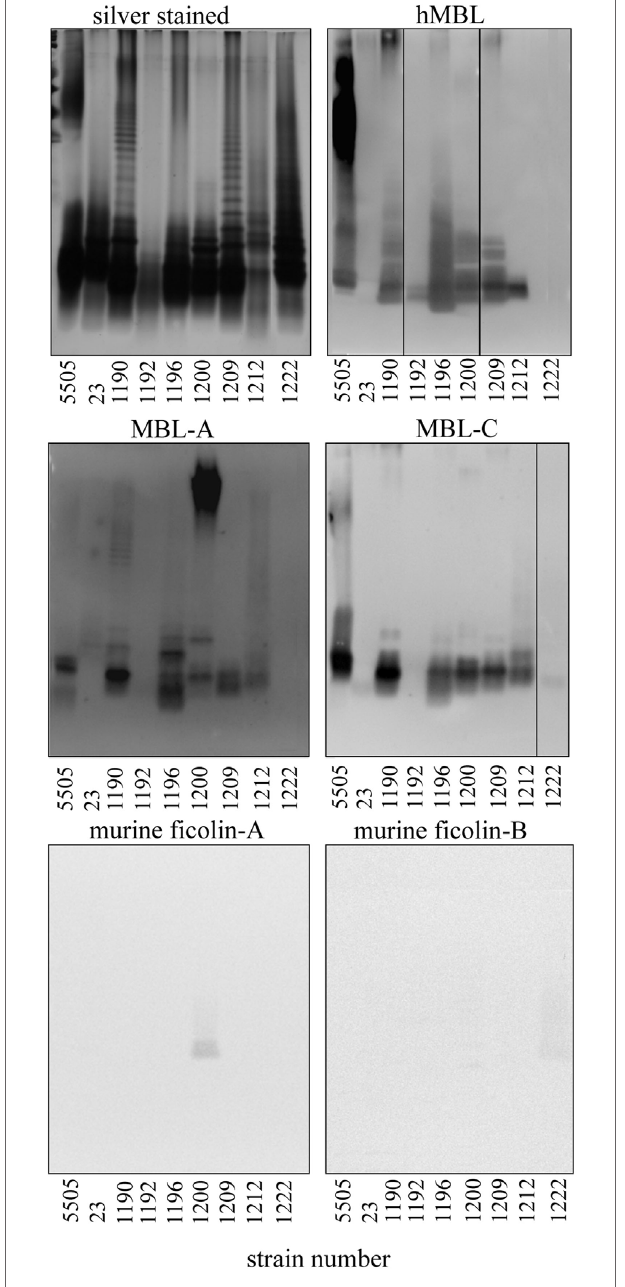
FigUre 3 | Silver stained SDS-PAGE of representative Hafnia alvei lipopolysaccharides (LPSs) and lectin blotting of their interactions with human MBL (hMBL) and murine mannose-binding lectin (MBL)-A, MBL-C, ficolin-A, and ficolin-B. Normal human serum and BALB/c mice sera were used as a source of hMBL or murine MBL-A, MBL-C, ficolin A, and B, respectively. Lanes are depicted with the strain number in Polish Collection of Microorganisms. Strain 5505 represents Klebsiella pneumoniae O3:K55 − LPS used as a positive